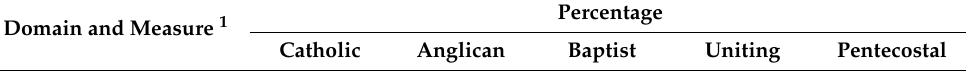
Item wordings and results for social cohesion domains, NCLS